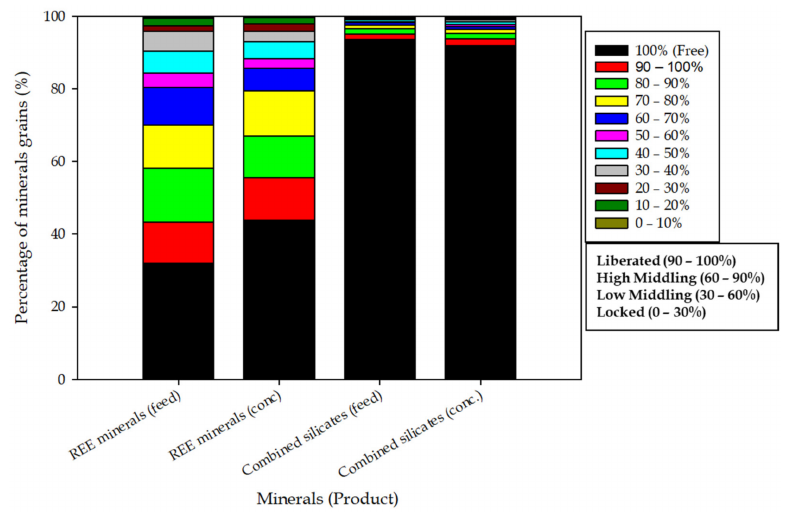
Figure 8. Liberation of the combined REE-bearing minerals and combined silicates in the flotation feed and